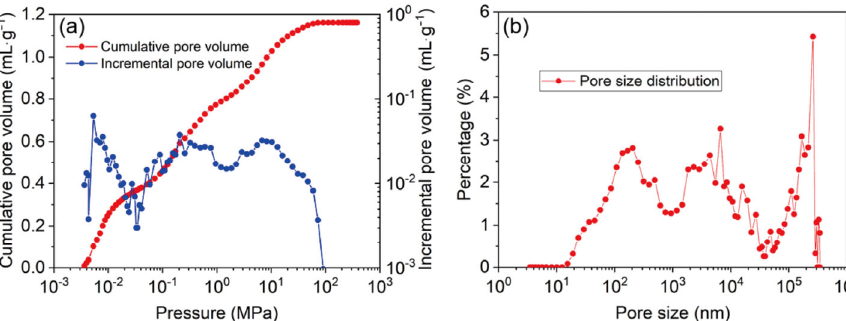
Fig. 5 Pore size and distribution of 3D printed grid porous electrodes: (a) cumulative and incremental pore volume versus pressure and (b) pore size